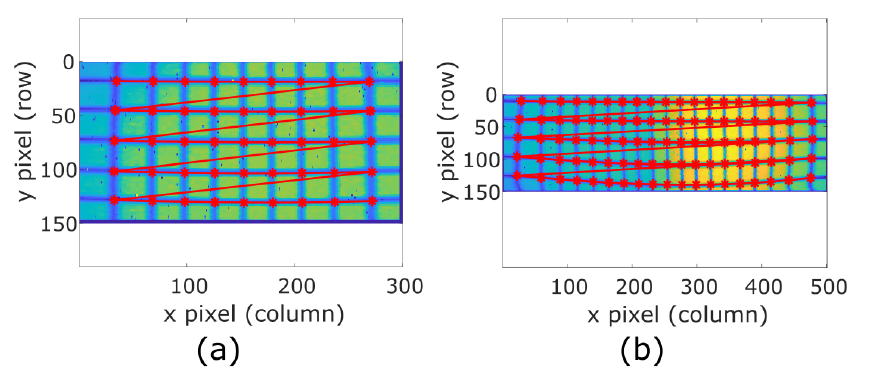
Figure 9. Grid control points on the odd image for both ( a ) 30 × 20 ◦ and ( b ) 50 × 20 ◦ FOV prototypes.